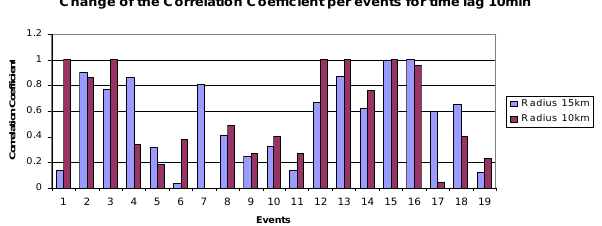
Fig. 9. The correlation coefficient for each event with a radius of 10km (in purple) and with a radius of 15km (in blue) and a time lag of 10min.